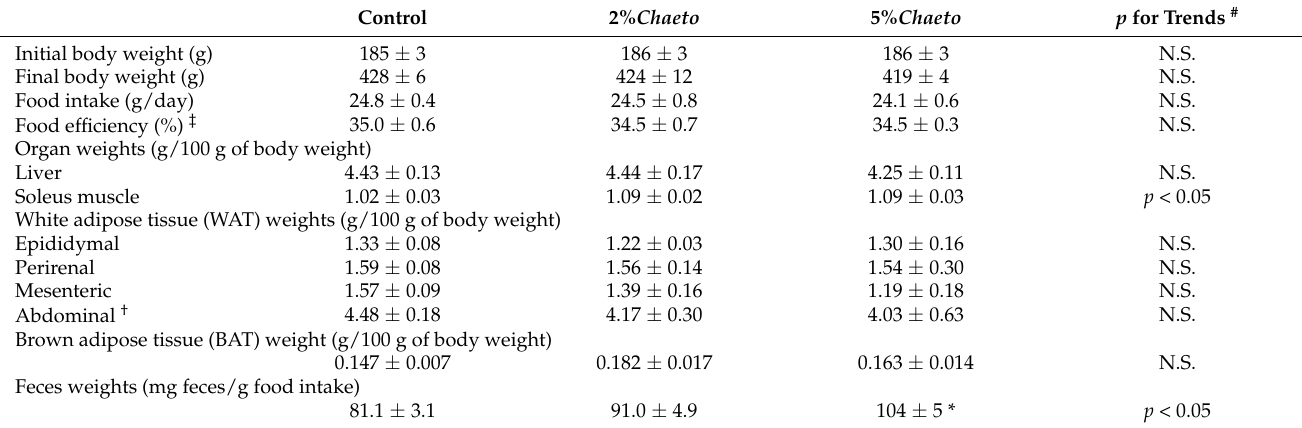
Figure 1. Macroscopic changes in the abdominal cavity of SD rats fed C. gracilis . Table 3. E ff ects of C. gracilis feeding on morphometric variables of SD rats.